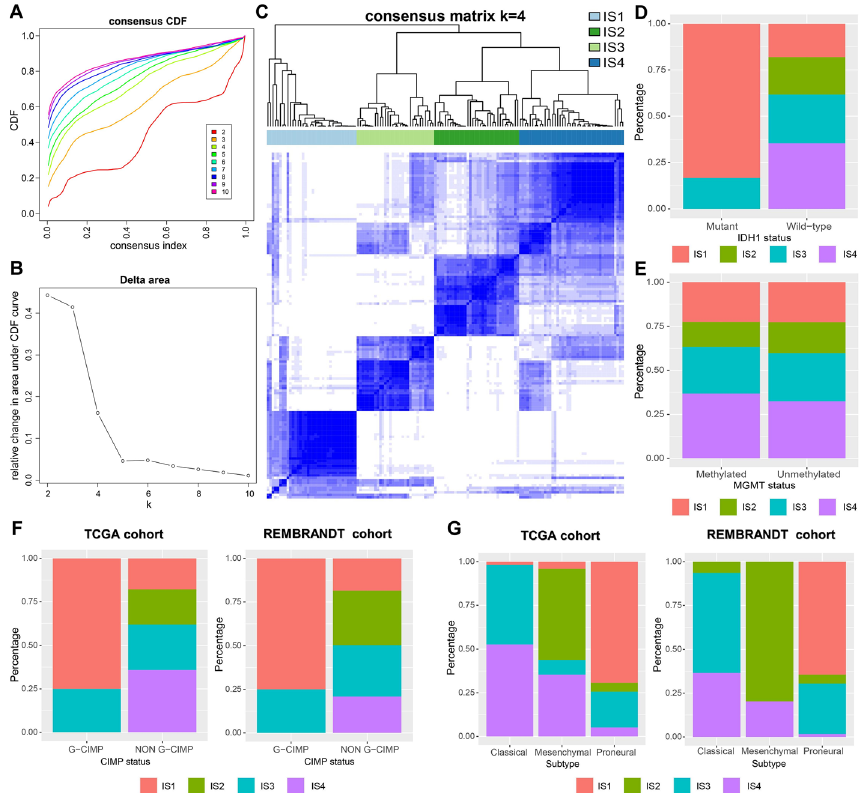
Fig. 3 Identification of potential immune subtypes in GBM. Cumulative distribution function curve ( a ), delta area curve ( b ) and consensus heatmap ( c ) based on immune-related gene expression profile in the